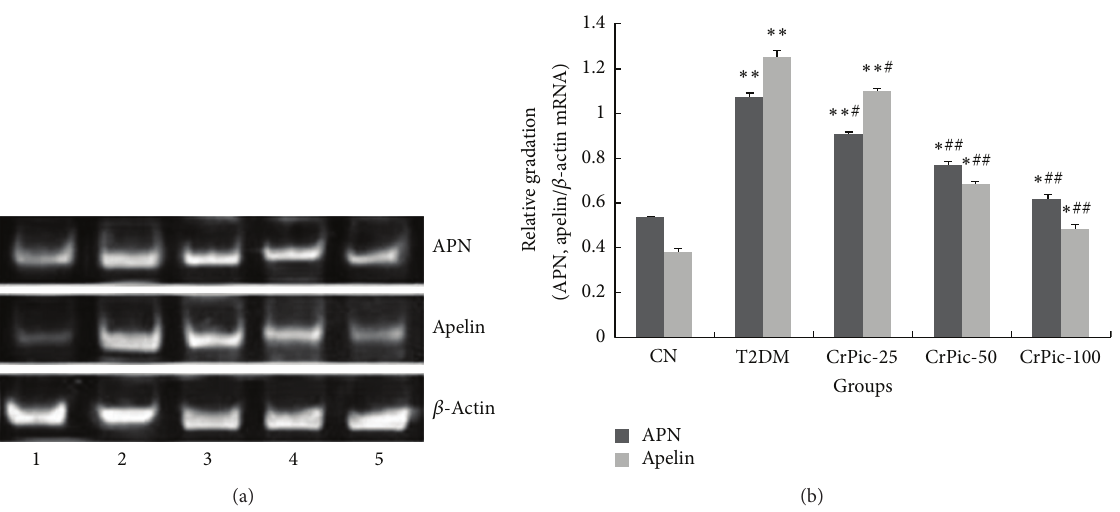
Figure 3: The mRNA expression levels of APN and apelin in each group. (a) Agarose gel electrophoresis of RT-PCR products. (b) The histogram of relative mRNA expression levels of APN and apelin compared with 𝛽 -actin . CN: the normal control group, group 1; T2DM: T2DM (type II diabetes mellitus) control group, group 2; CrPic-25: group 3 (25 𝜇 g/kg); CrPic-50: group 4 (50 𝜇 g/kg); and CrPic-100: group 5 (100 𝜇 g/kg). ∗∗ 𝑃 < 0.01 compared with group 1; ∗ 𝑃 < 0.05 compared with group 1; ## 𝑃 < 0.01 compared with group 2; and # 𝑃 < 0.05 compared with group